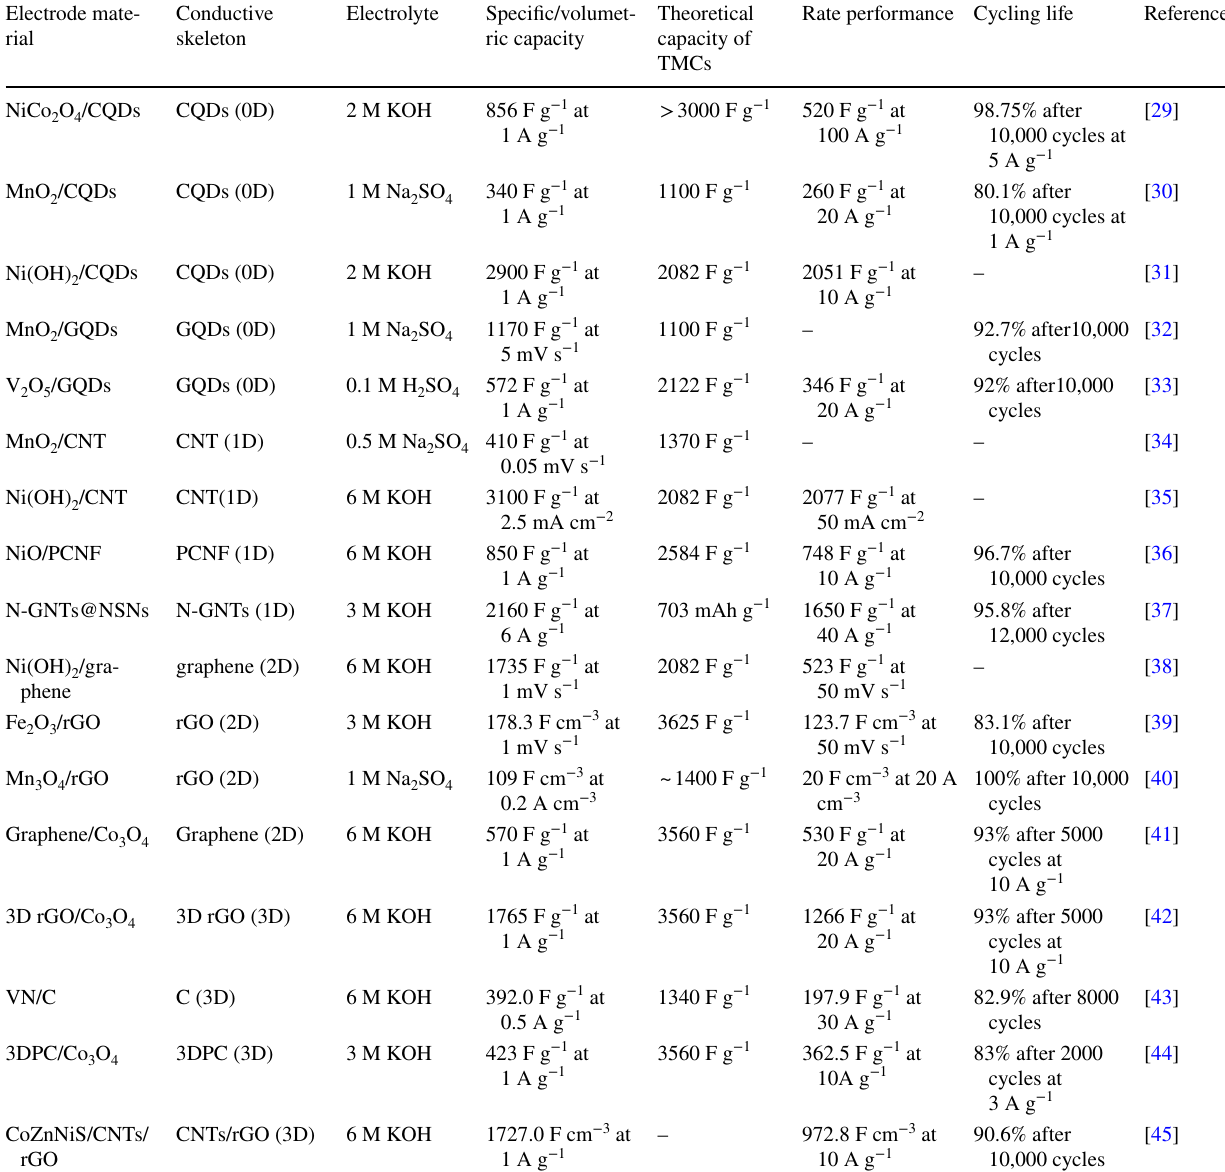
Table 1 Different dimensional carbon based electrode materials Electrode mate- Conductive rial